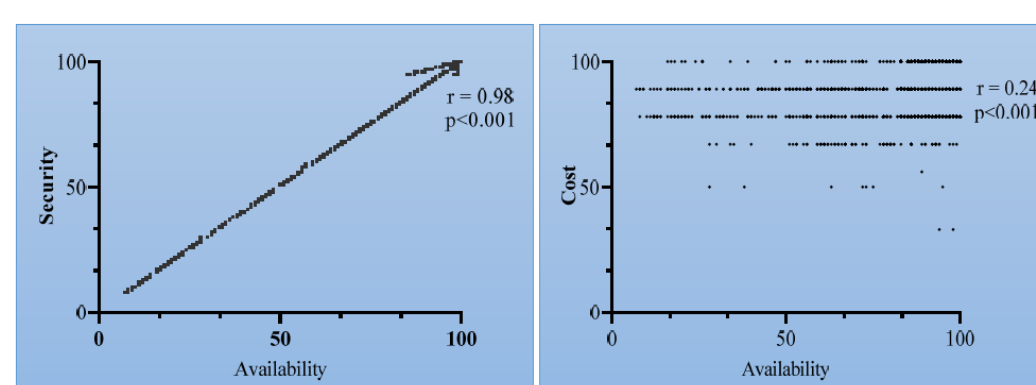
Table 2. Correlation Analysis.